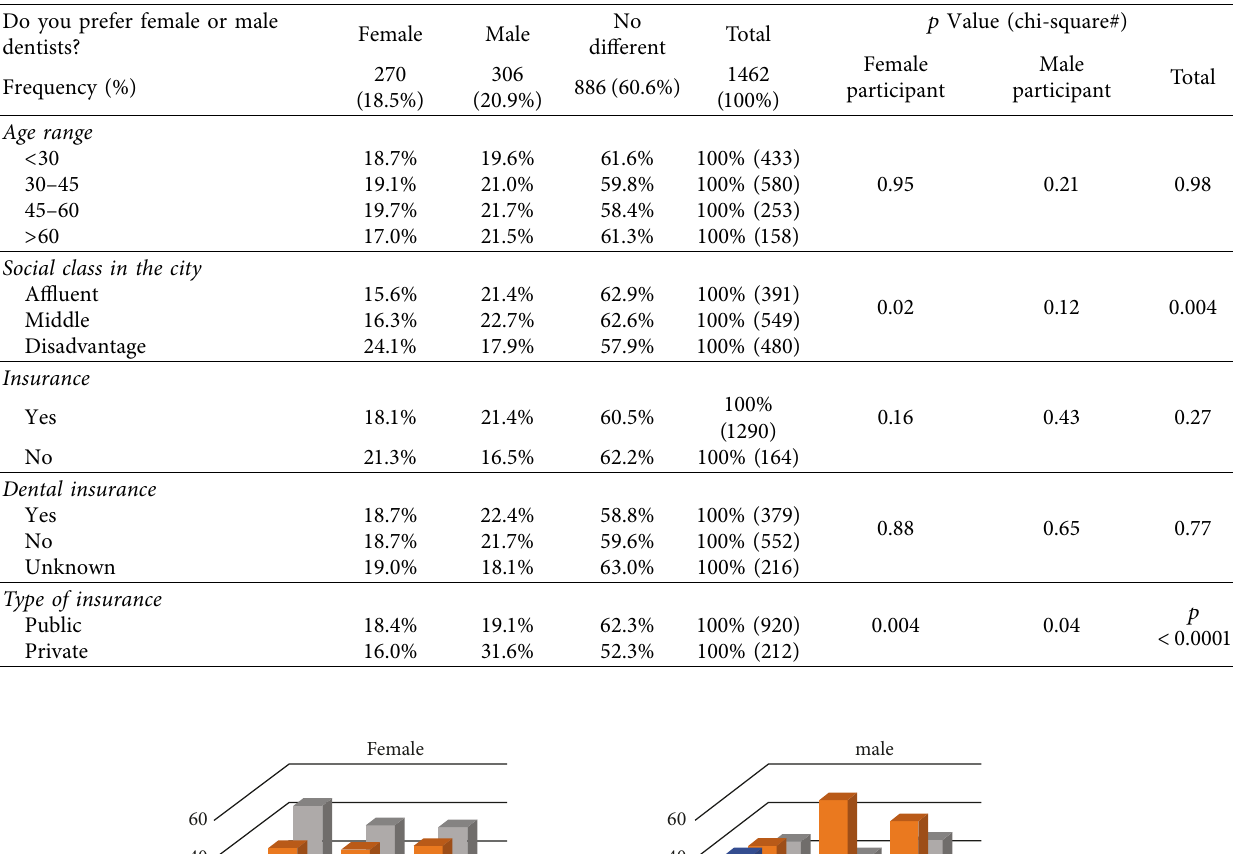
Table 5: Patient preferences for dentist’s gender.